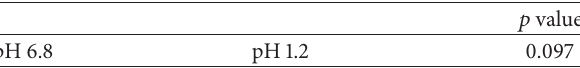
Table 2: Effect of pH of simulated gastrointestinal fluids on MAC. This shows that there is no significant effect of pH in the